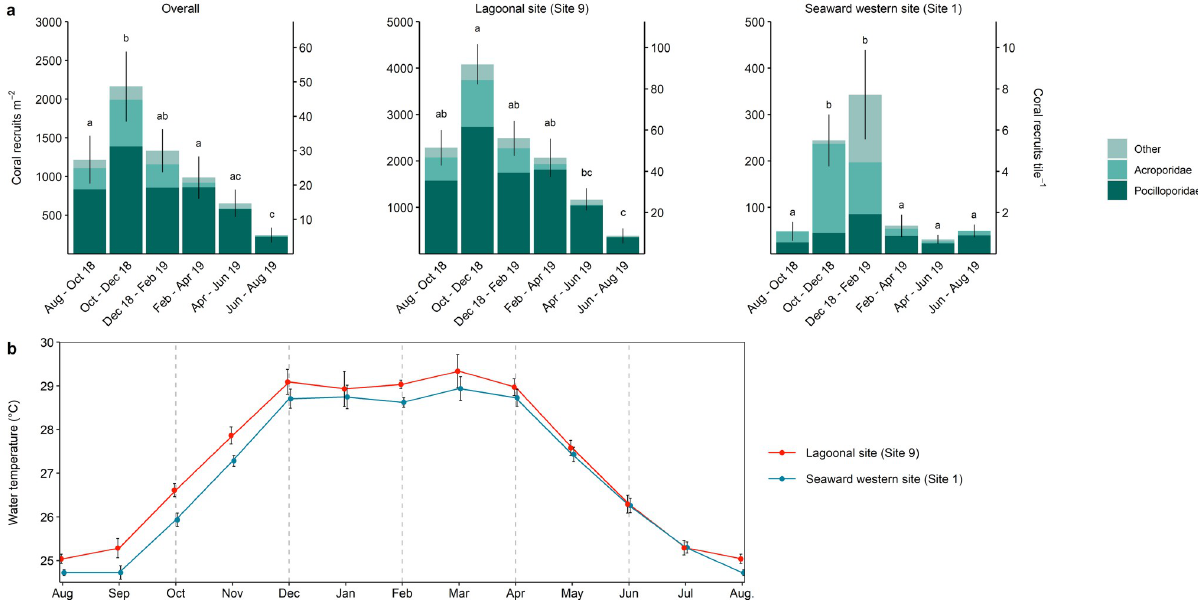
Fig 4. Results of coral recruit study. (A) Coral recruit abundances overall and at each site. Values represent mean abundance for each taxon and in total, SE is displayed for total mean abundance only. Secondary y-axis indicates number of coral recruits per tile. Note the different y-axis scaling. Letters indicate significant differences ( p < 0.05) between study periods (see S4 Table). (B) Mean ( ± SE) monthly water temperature during December 2013–Dec 2019 at the seaward western site and during February 2015–November 2018 at the lagoonal site where technical issues prevented the inclusion of data until December 2019. Horizontal dashed lines indicate month of settlement tile